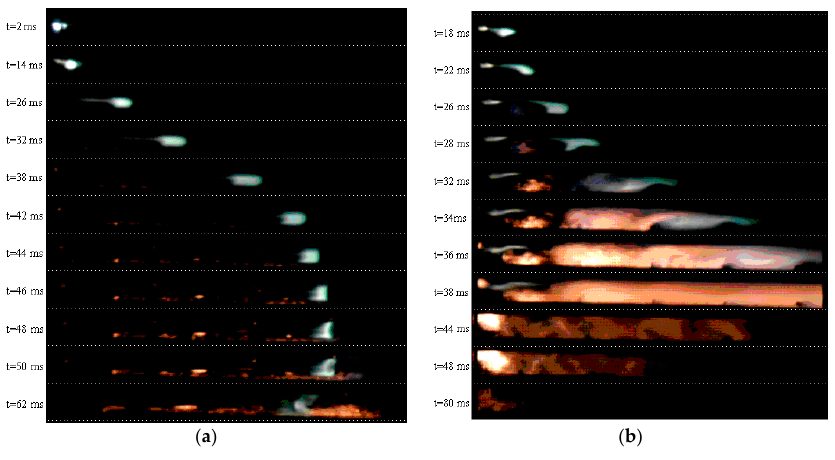
Figure 4. High-speed photographs of flame propagation, 9.47 vol % CH 4 , ( a ) no obstacle; and ( b